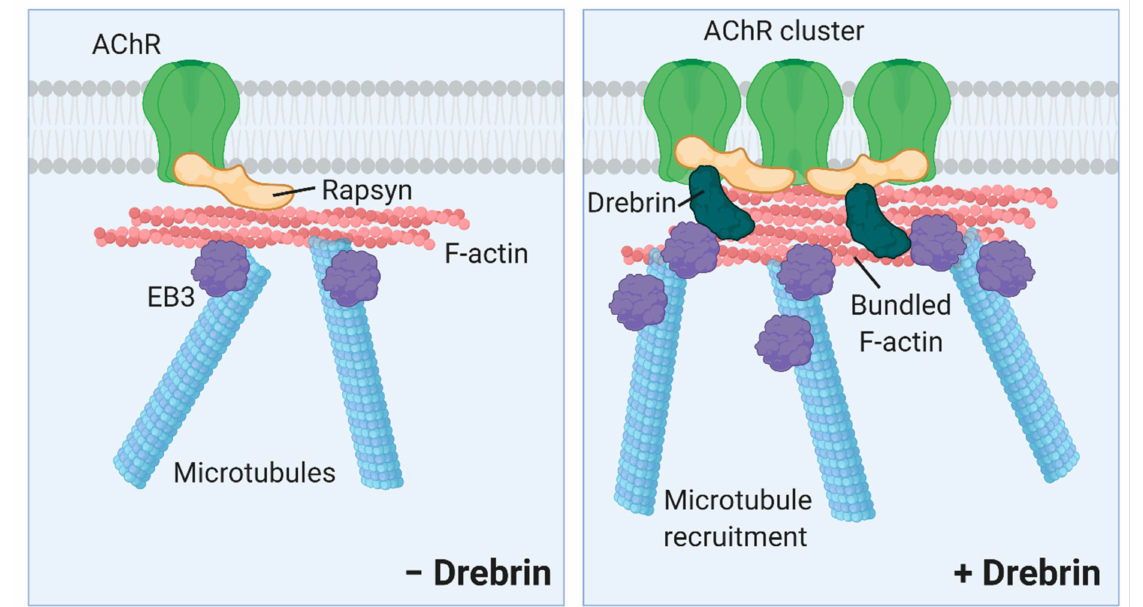
Figure 9. Proposed model of drebrin role in the regulation of postsynaptic machinery clustering. Rapsyn anchors AChRs to actin and microtubules ( − Drebrin). Drebrin bundles actin filaments and acts as a cross-linker between actin cytoskeleton and microtubule network under AChR clusters. Drebrin interacts with rapsyn, a cluster-stabilizing protein, and EB3, a microtubule plus-end protein, and recruits microtubules under AChR clusters (+ Drebrin). Illustration created with BioRender.com (www.biorender.com, last access 26 August